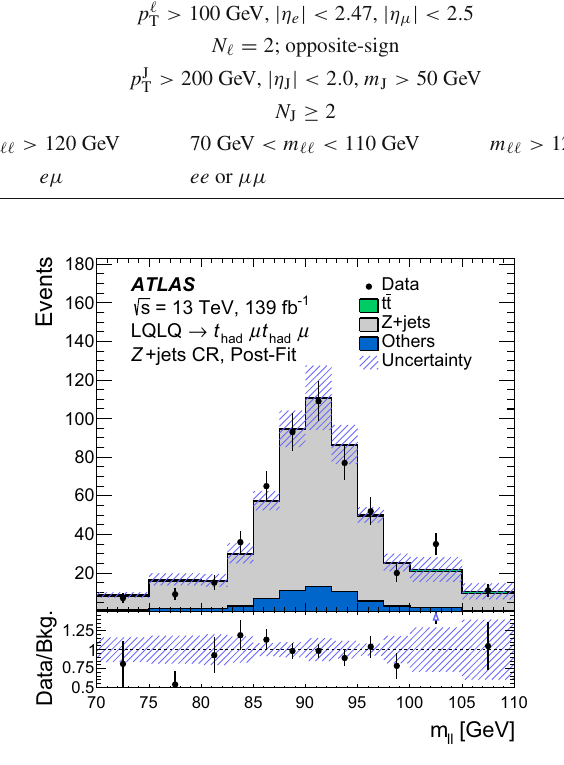
Fig. 2 Distributions of the reconstructed W mass associated with the leading lepton assuming a dileptonic hypothesis in the t ¯ t CR after the simultaneous background-only fit of the electron channel CRs (left), and the dilepton invariant mass m (cid:5)(cid:5) in the Z + jets CR after the simulta-